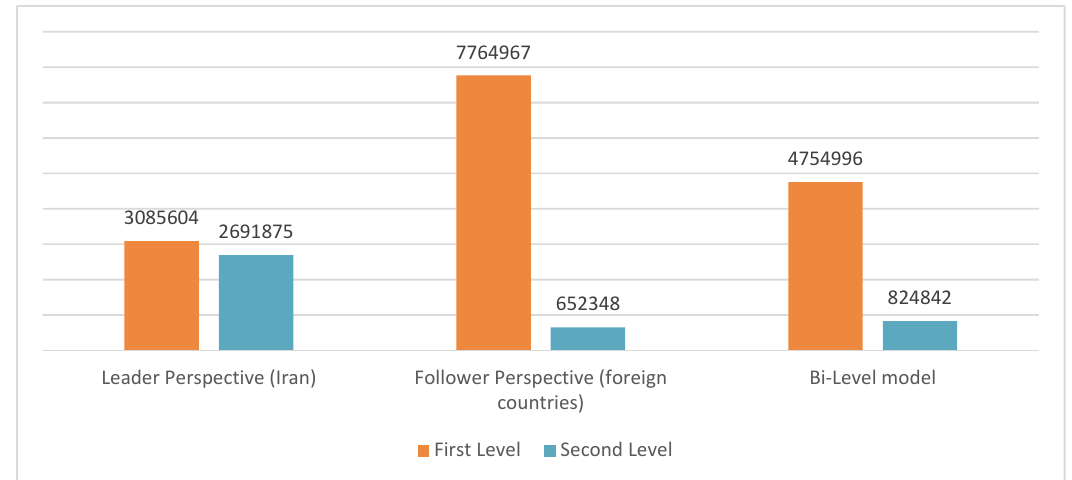
Fig. 3. The objective functions from different points of view Percentage of increase in the respective models against the best decision Increase in international suppliers Increase in Iran total costs Leader perspective